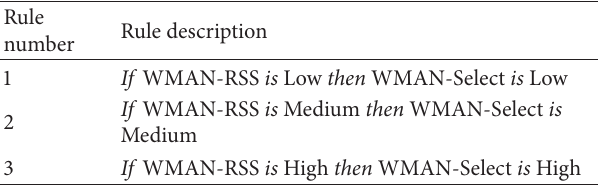
Table 3: Rule set for WMAN-RSS.